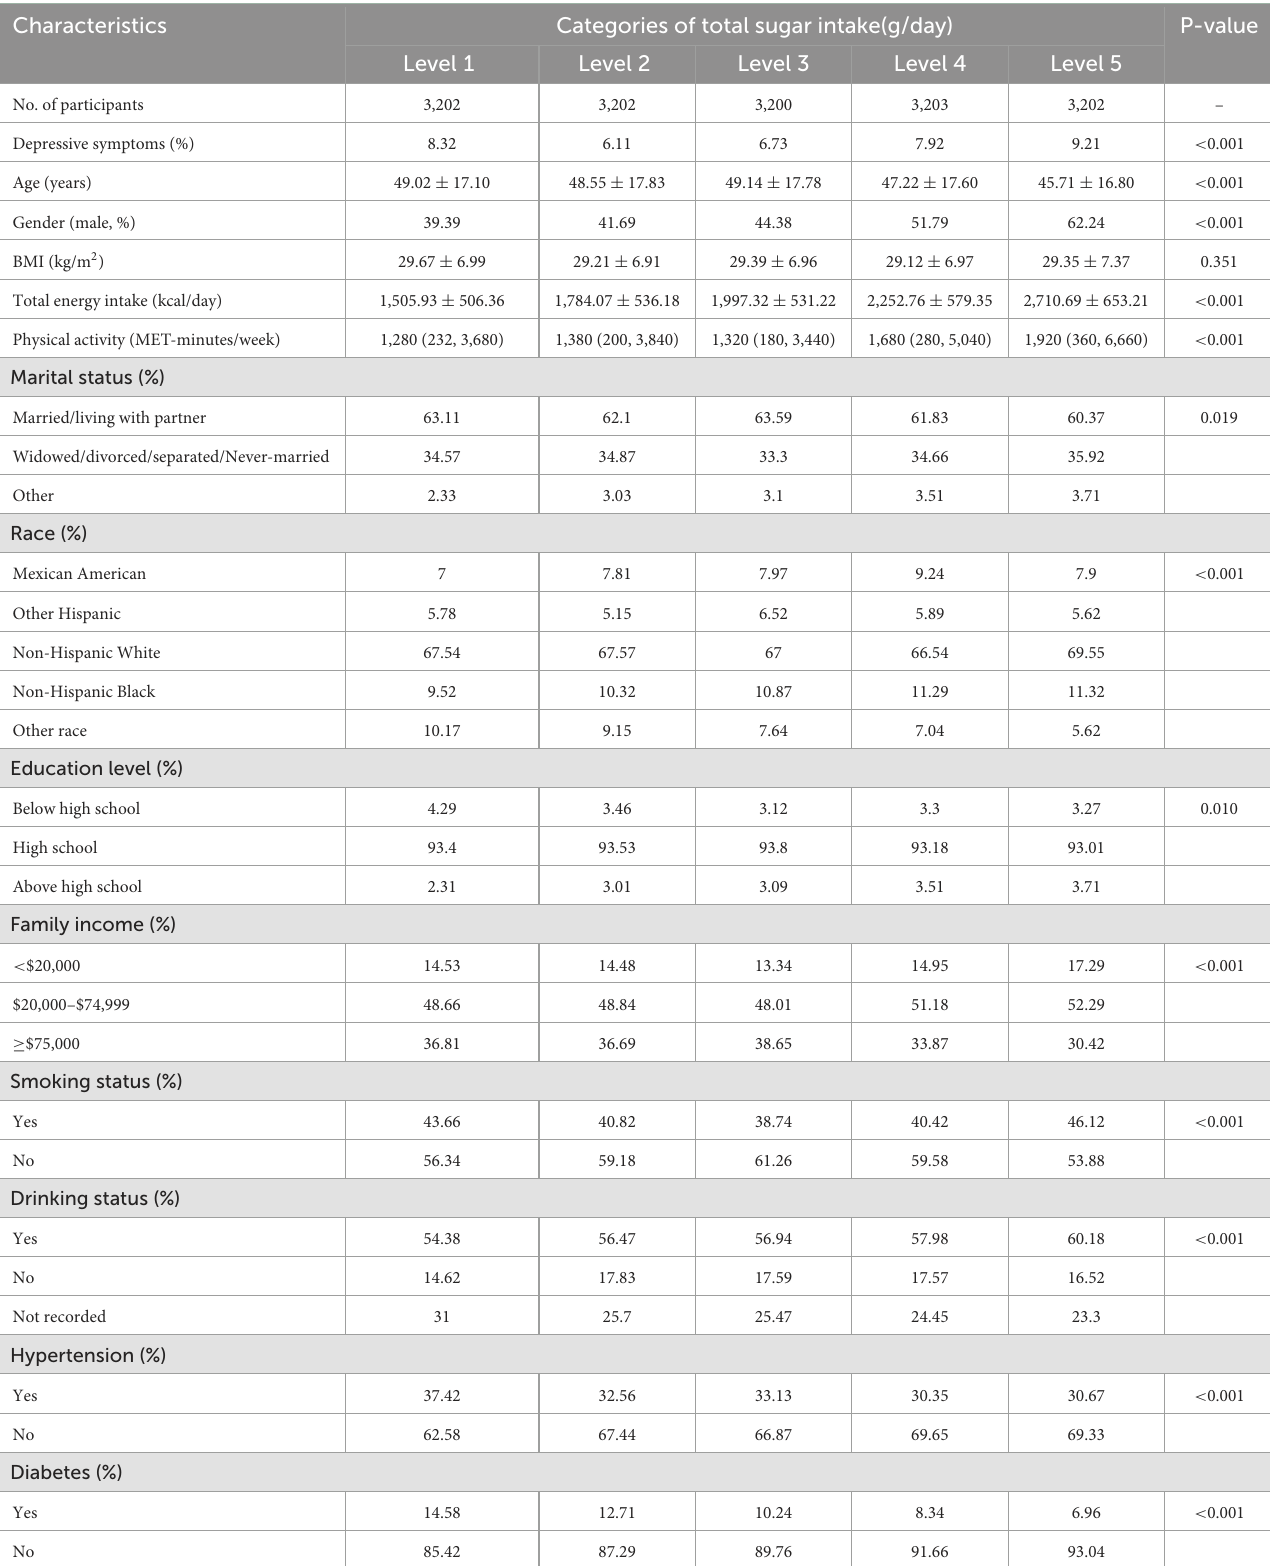
TABLE 1 Participant characteristics according to sugar